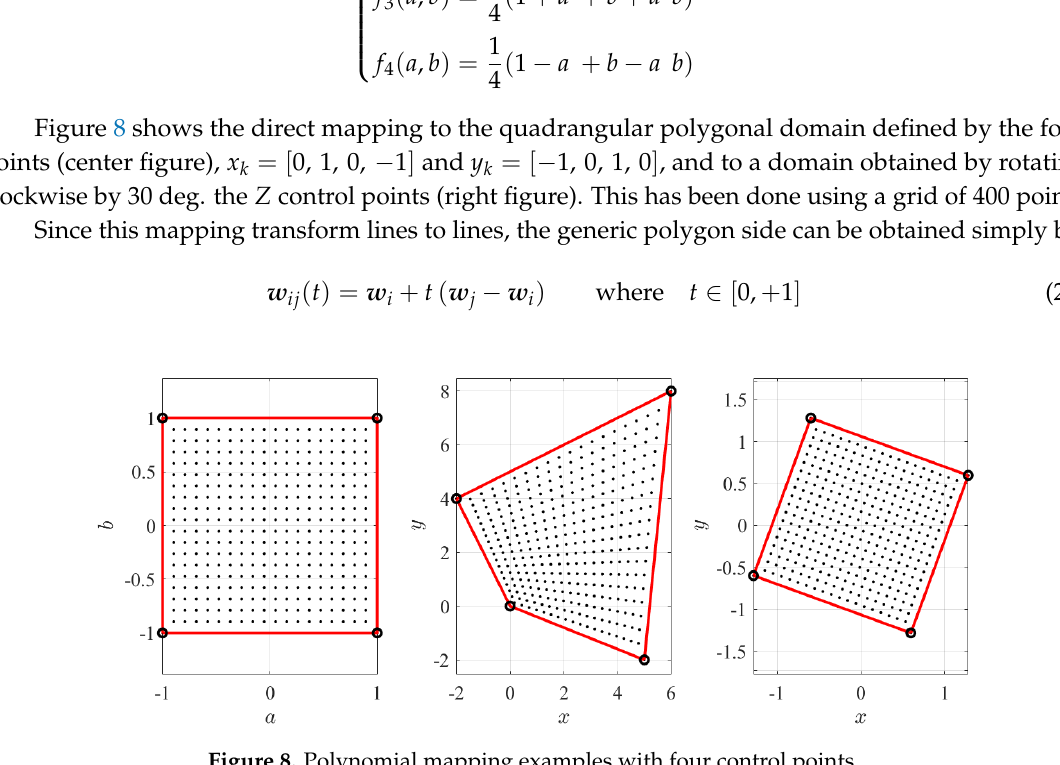
Figure 8. Polynomial mapping examples with four control